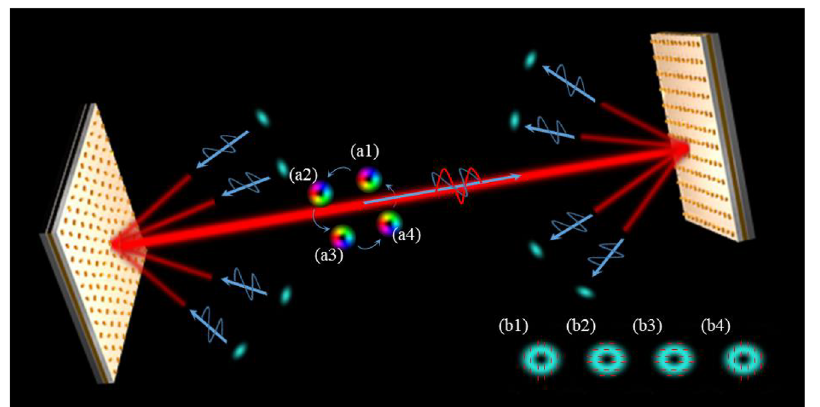
Figure 1: The mechanism of (de)multiplexing with polarization and OAM mode. X -polarized Gaussian beams incident on the multiplexer at different diffraction angles. Then the VBs with different OAM modes and x - or y -polarization states can be generated and coaxially transmit along with the zeroth diffraction order. At receiver, the OAM mode and polarization channels are reconverted into Gaussian beams and separated spatially for detection by the demultiplexer. (a1)–(a4) The complex amplitude distribution of four reflected beams. (b1)–(b4) The polarization distribution of four reflected